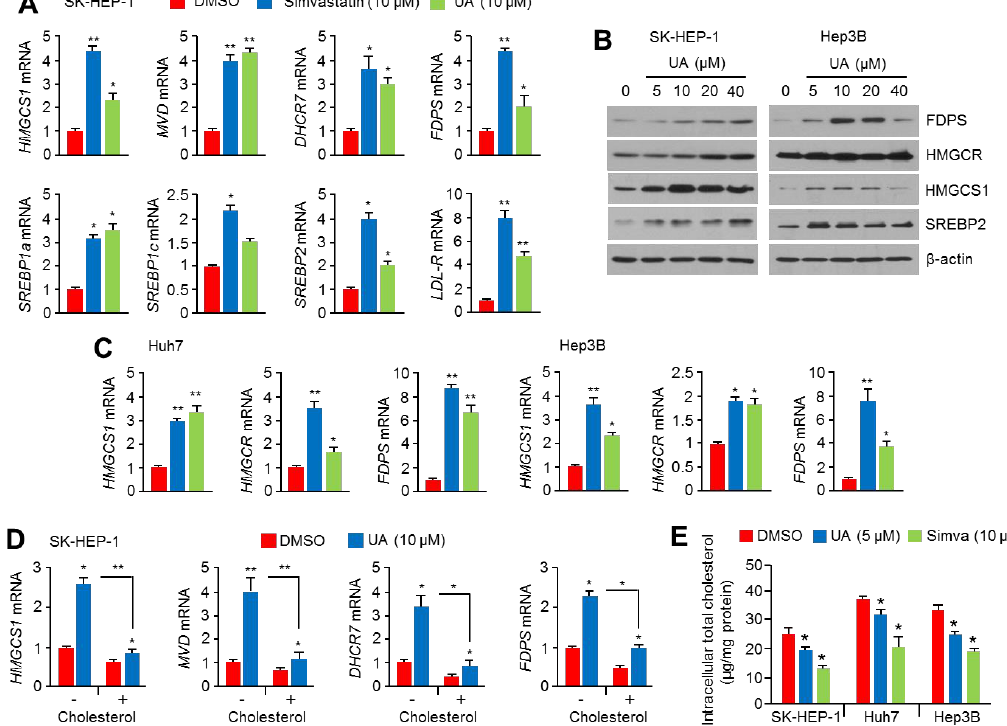
Figure 2. UA increases the expression of cholesterol biosynthesis-related genes and enzymes in hepatocellular carcinoma (HCC) cells. ( A ) SK-HEP-1 cells were incubated with UA (20 µ M) or simvastatin (10 µ M) for 24 h. The mRNA levels were measured by quantitative real-time polymerase chain reaction (PCR). The values represent the mean ± SD from three independent experiments performed in duplicate; * p < 0.05 and ** p < 0.01. ( B ) SK-HEP-1 and Hep3B cells were incubated with UA for 24 h at di ff erent concentrations, as indicated. Protein expression was measured by western blotting. ( C ) Huh7 and Hep3B cells were incubated with UA (20 µ M) or simvastatin (10 µ M) for 24 h, following which, the mRNA levels were measured. The values represent the mean ± SD from three independent experiments performed in duplicate; * p < 0.05 and ** p < 0.01. ( D ) SK-HEP-1 cells were incubated with or without 0.5 mM of water-soluble cholesterol for 6 h prior to UA (20 µ M) treatment, followed by further incubation with DMSO or UA (20 µ M) for 24 h. The values represent the mean ± SD from two independent experiments performed in triplicate; * p < 0.05 and ** p < 0.01. ( E ) Intracellular total cholesterol levels were measured in UA or simvastatin-treated SK-HEP-1, Huh7 and Hep3B cells. UA or simvastatin was treated for 48 h prior to measure intracellular total cholesterol. The values are represented as the mean ± SD of three independent experiments performed in duplicate; * p < 0.05.